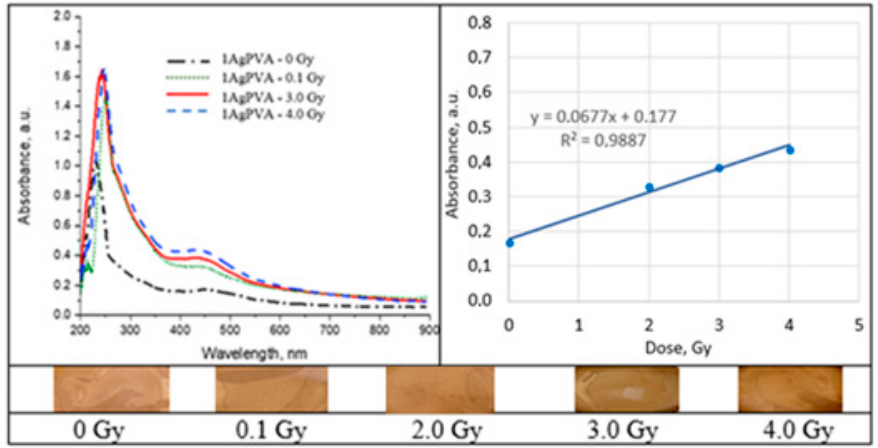
Figure 10. Absorbance and sensitivity of the 6 MeV irradiated 1AgPVA films.